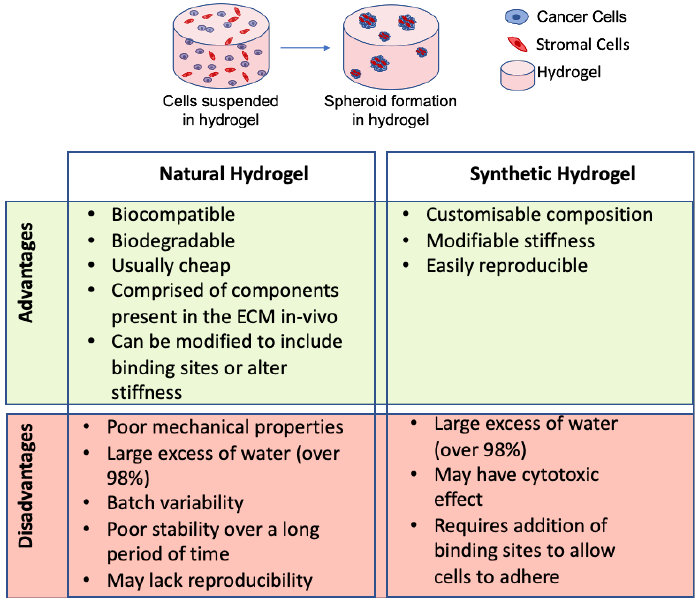
Figure 4. Advantages and disadvantages of natural and synthetic hydrogels. This diagram illus- trates cells suspended in hydrogel and forming spheroids. This represents the use of hydrogels in the development of 3D models of CRC [116,122]